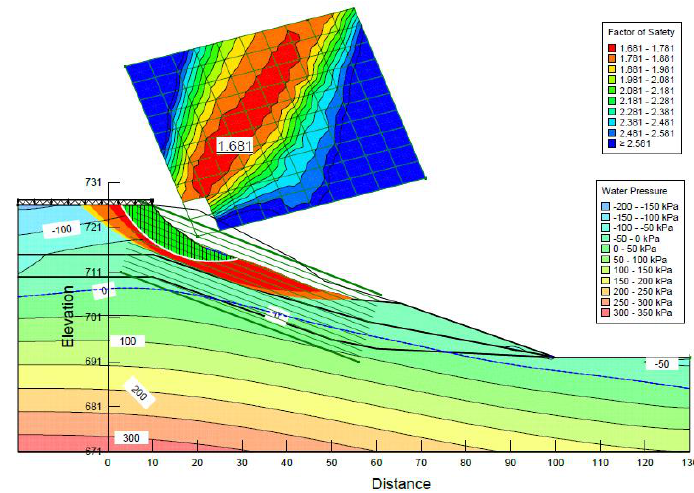
Figure 21. Post-failure stability after 4.5 h with a flux of 144 mm/day.